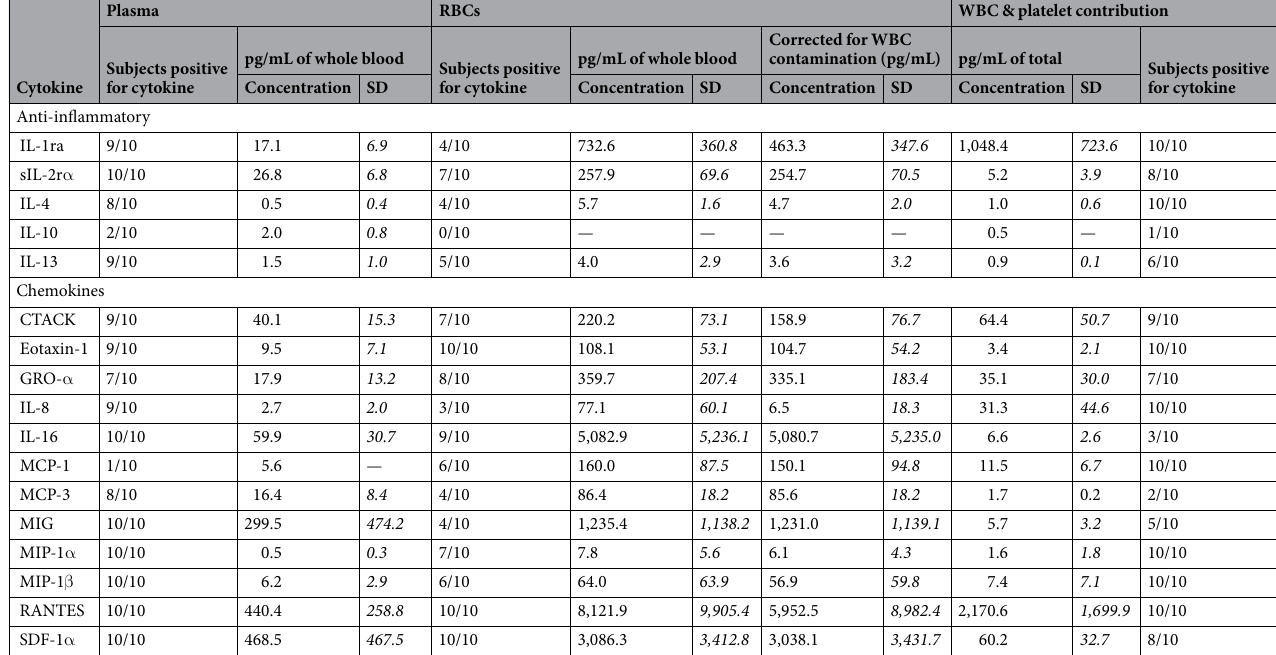
Table 2. Concentration of anti-inflammatory cytokines and chemokines in EDTA plasma and RBCs in one millilitre of whole blood with correction for white blood cell (WBC) and platelet contamination ( n = 10), data are presented as mean ±